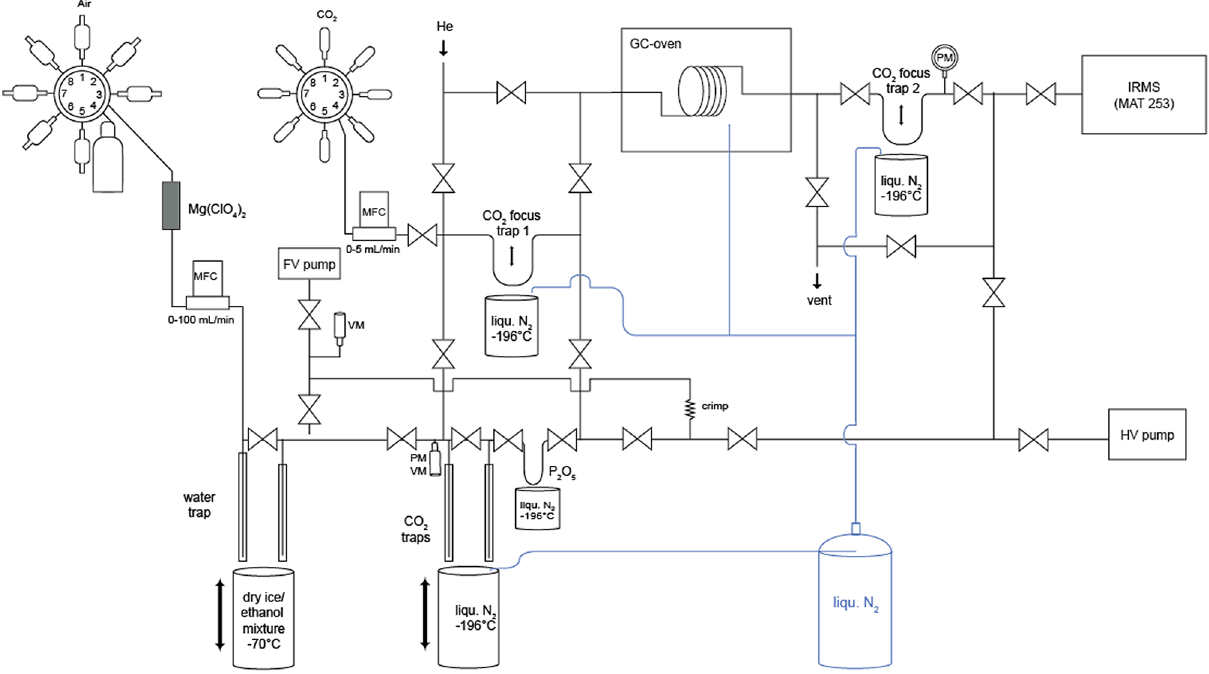
Figure 5. Schematic of the automated system for CO 2 extraction from air and purification system. The liquid nitrogen tank is connected to the Dewar using Teflon tube covered with a temperature